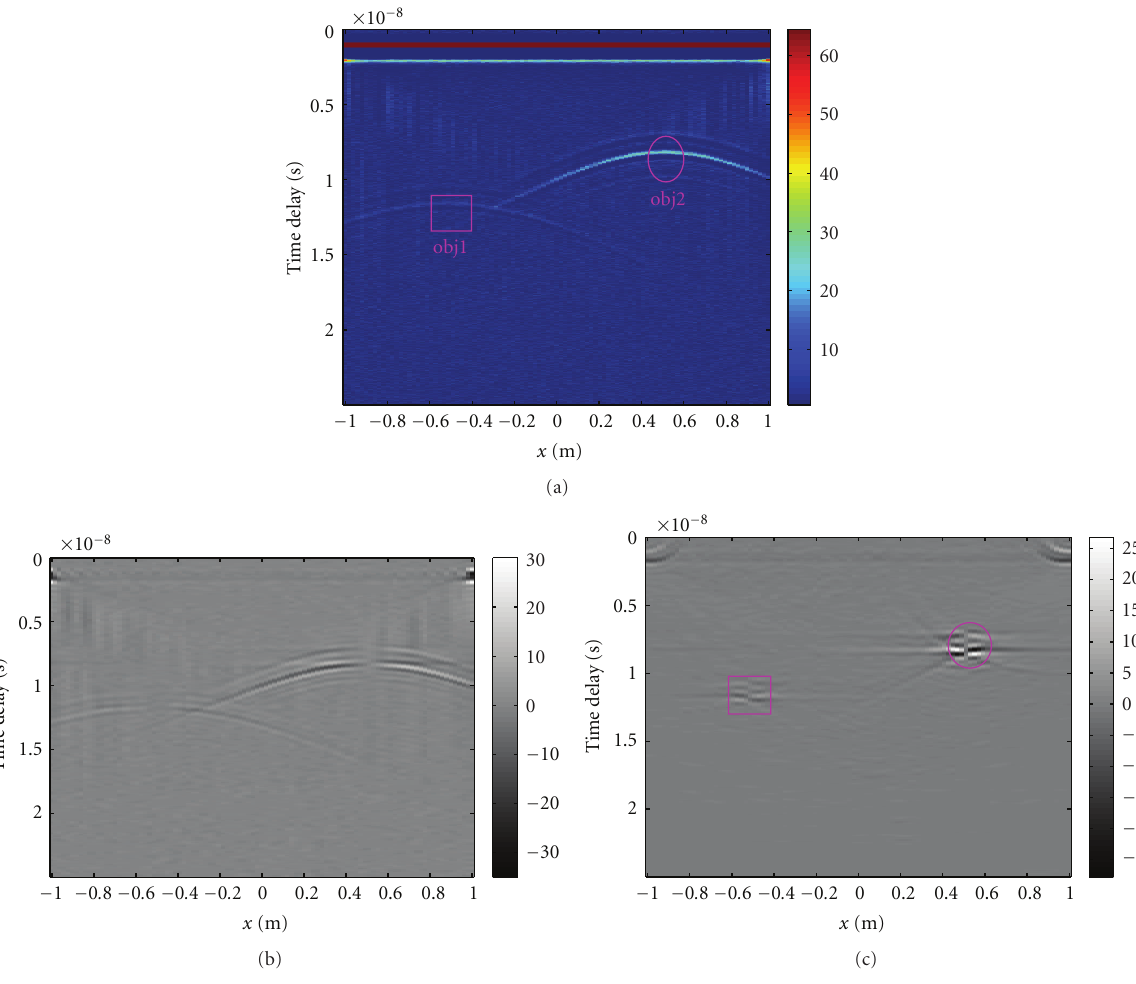
Figure 6: Preprocessing results of subsurface. (a) Forward profile. (b) FK filtered result. (c) FK migration